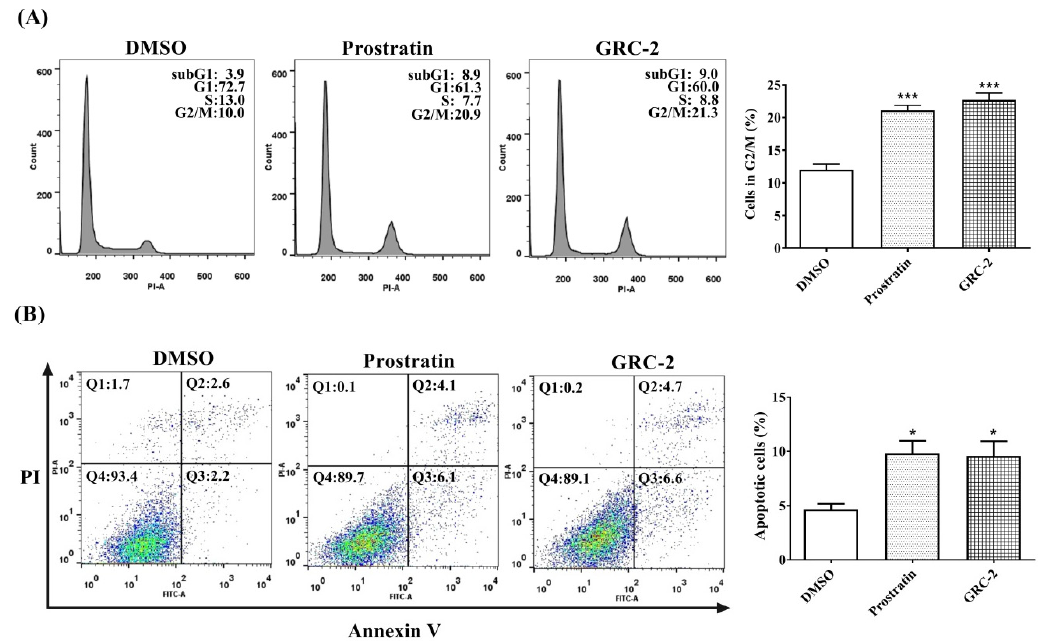
Figure 2. Prostratin and GRC-2 induce cell cycle arrest and apoptosis. A549 cancer cells were treated with DMSO, prostratin or GRC-2 for 72 h. ( A ) Cell cycle distribution and ( B ) apoptosis were measured by PI staining and annexin V/PI double staining, respectively. Apoptotic cells are presented in the right-lower (Q3, early apoptosis) and right-upper (Q4, late apoptosis) quadrants of the plots. Results are presented as mean ± S.E.M. ( n = 3). * p < 0.05 and *** p < 0.001 as compared with the vehicle control.